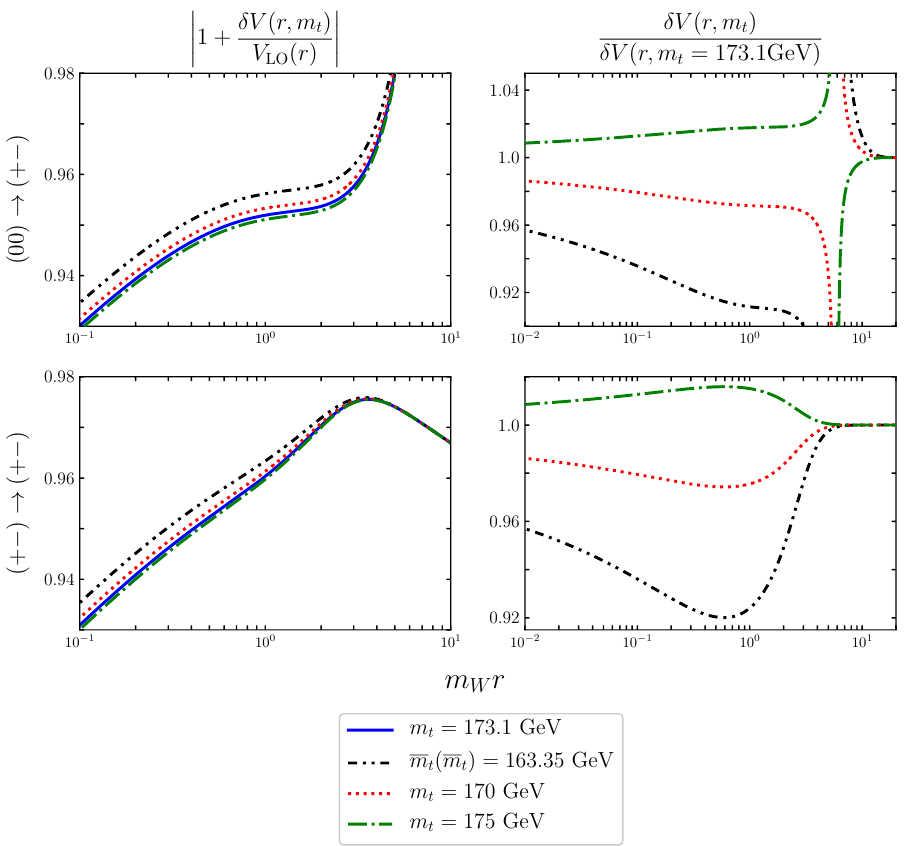
Figure 5 . Ratio of the NLO potential to the LO potential (left panel) and the ratio of the correction vs. the correction for the reference value m t = 173 . 1 GeV (right panel) for various values of top mass. The upper panel gives the channel (00) → (+ − ) and the lower panel (+ − ) → (+ − ) . The lines refer to m t = 173 . 1 GeV (blue/solid), 163 . 35 GeV (black/dot-dot-dashed), 170 GeV (red/dotted), and 175 GeV (green/dot-dashed) all in the on-shell renormalization scheme for the couplings. light fermions. In the χ 0 χ 0 → χ + χ − channel, the singularity of the ratio around m in the right panel is an artefact of showing the ratio, as δV ( r, m different m -dependent values of r t